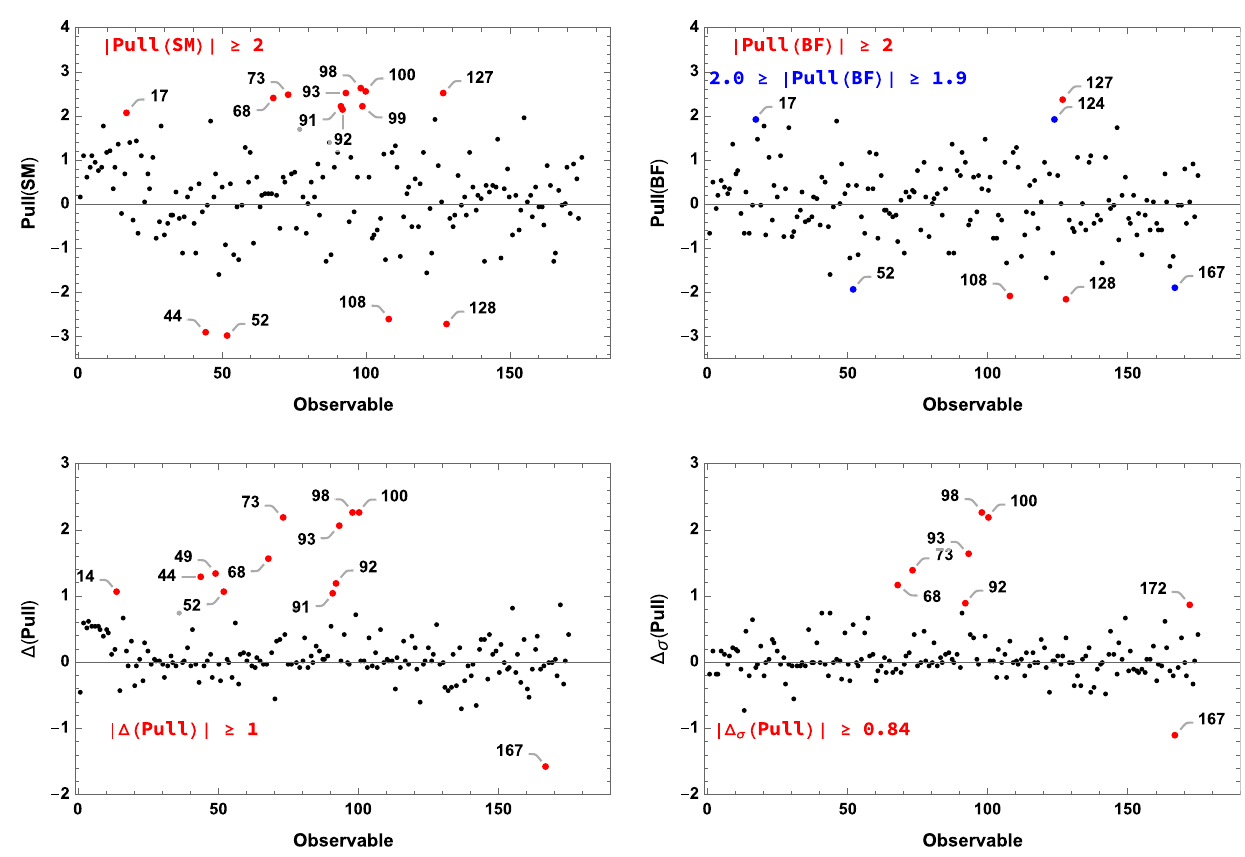
Fig. 4 The top panels show the Pull of each observable with respect to theSM(left)andthebestfit(right).Thebottompanelsshow (cid:11)( Pull ) for all observables ignoring correlations (left) and with correlations (right).